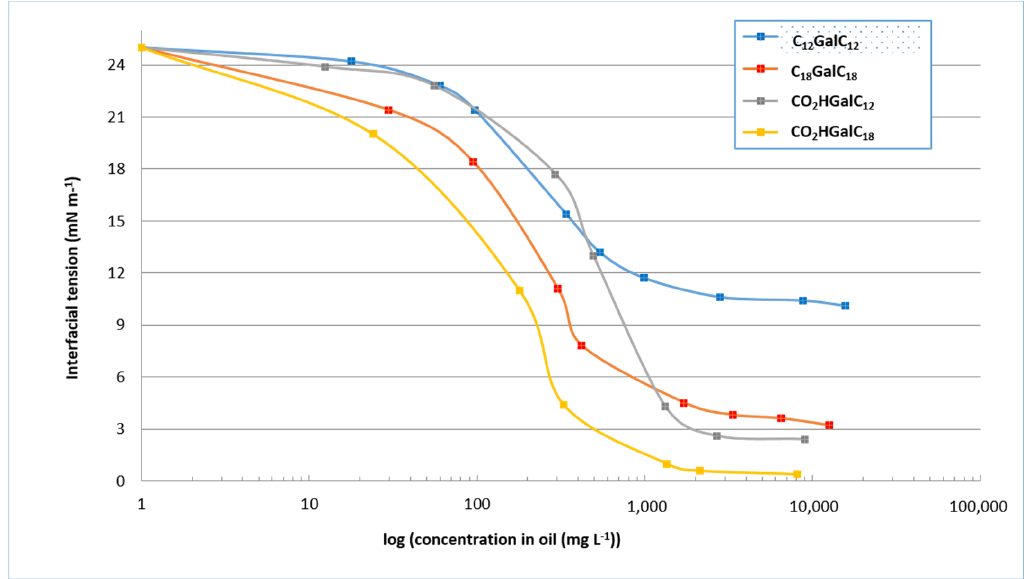
Figure 6. Values of interfacial tension of purified compounds C n GalC n and CO 2 HGalC n .